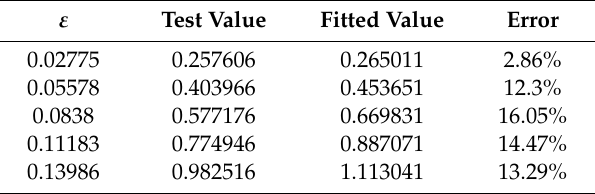
Table 6. The deviation between the tested stress and the fitted stress for specimen 1 under 300 ◦ C. ε Test Value Fitted